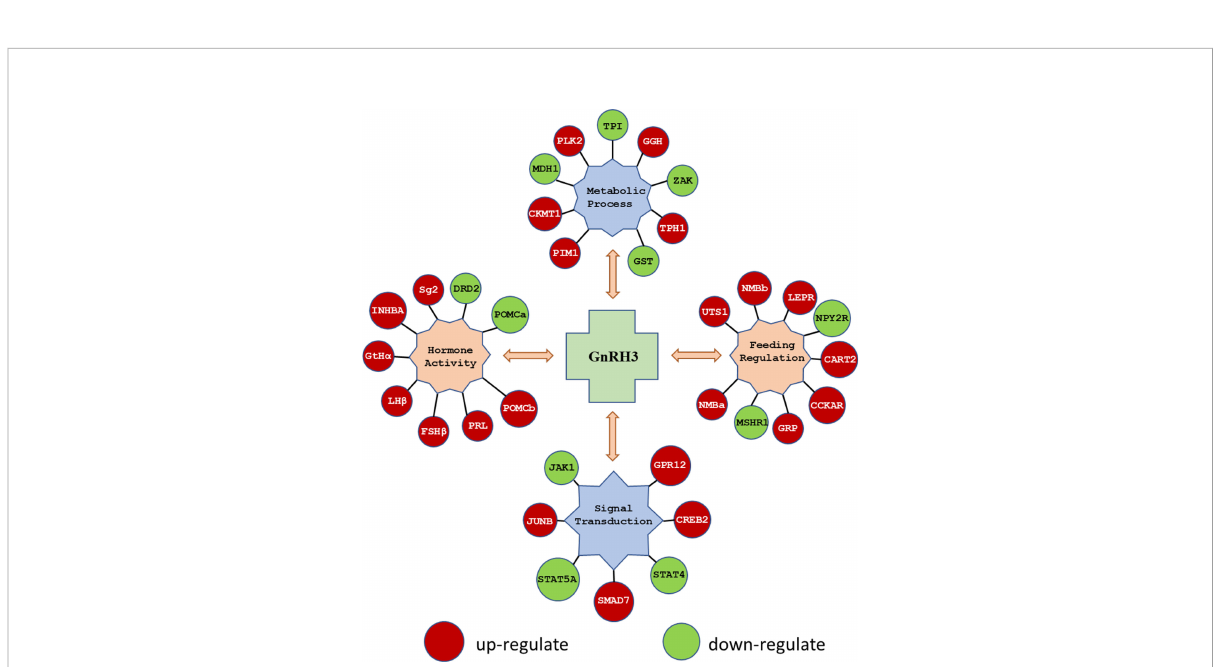
FIGURE 4 The key DEGs were selected to display the regulation of GnRH3 in signal transduction, feeding regulation, hormone activity, and metabolic process. The DEGs in red bubbles indicated the upregulated genes, and the DEGs in green bubbles indicated the downregulated genes by GnRH3 in grass carp pituitary